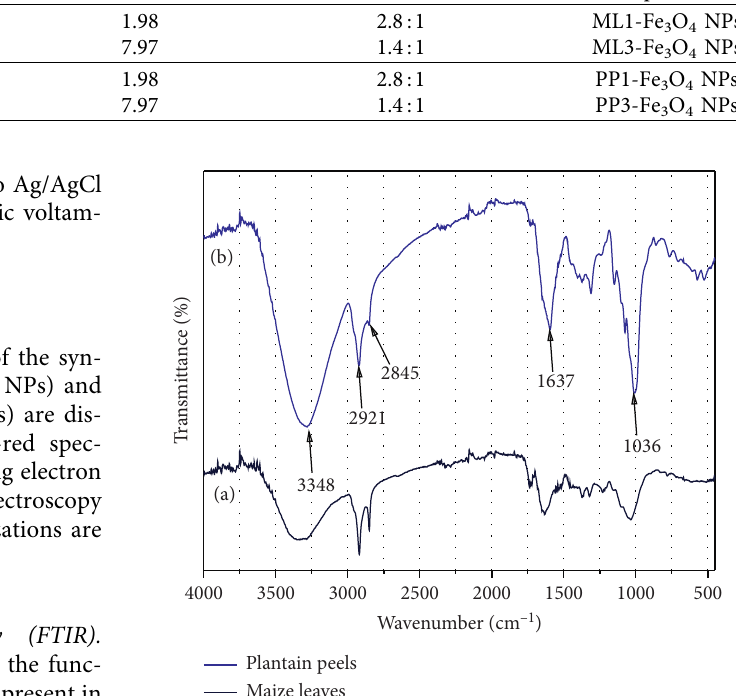
Table 1: The molar ratio of precursors used for the synthesis of nanoparticles. Extract used